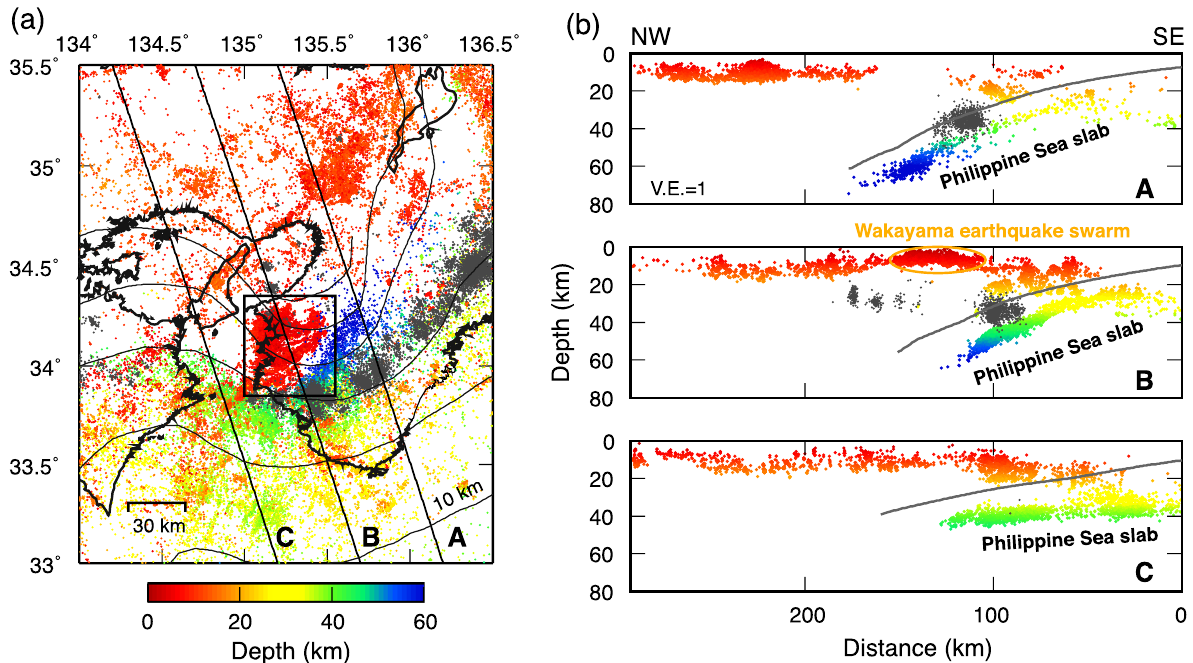
Fig. 2 Seismicity around the Wakayama earthquake swarm. a Map showing the M Gray dots denote low-frequency earthquakes. Black contours denote the iso-depth contours of the PHS slab at a 10-km interval. The rectangle denotes the Wakayama swarm. b Vertical cross sections of the earthquakes within swarm is shown by an orange ellipse in profile B. The upper surface of the PHS slab is shown by the gray line in each cross